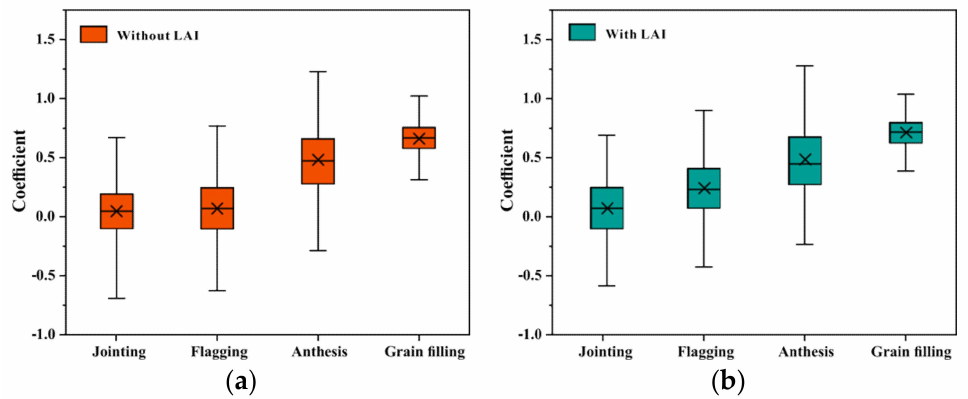
Figure 7. The distribution of regression coefficients for each growth stage within the level-2 model (ENET). ( a ) Without LAI; ( b ) With